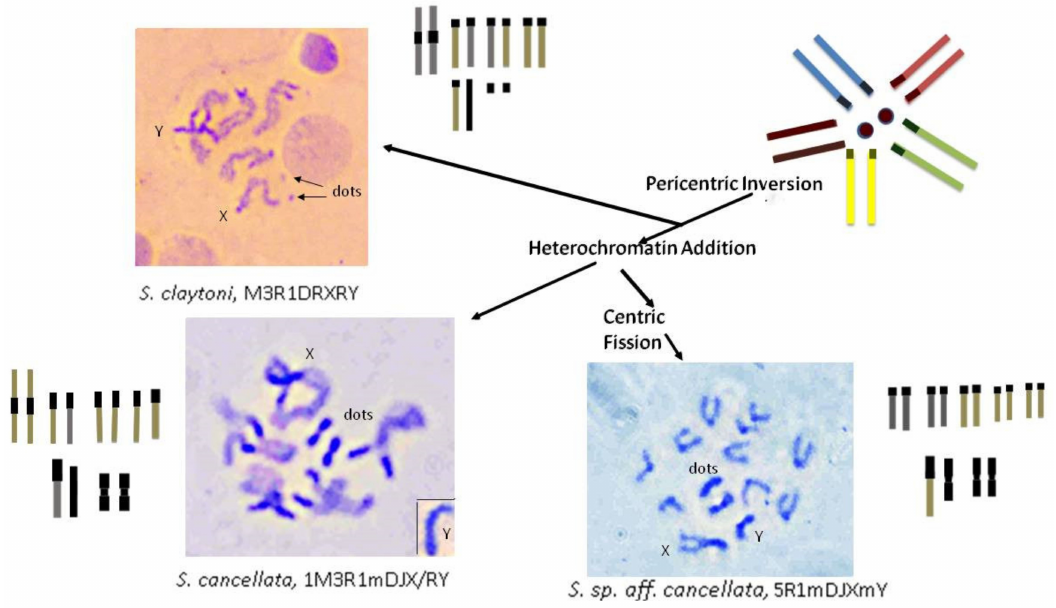
Figure 9. A scheme showing possible chromosome changes from an ancestral five acrocentric plus dot karyotype that could have given rise to members of the coracina group of